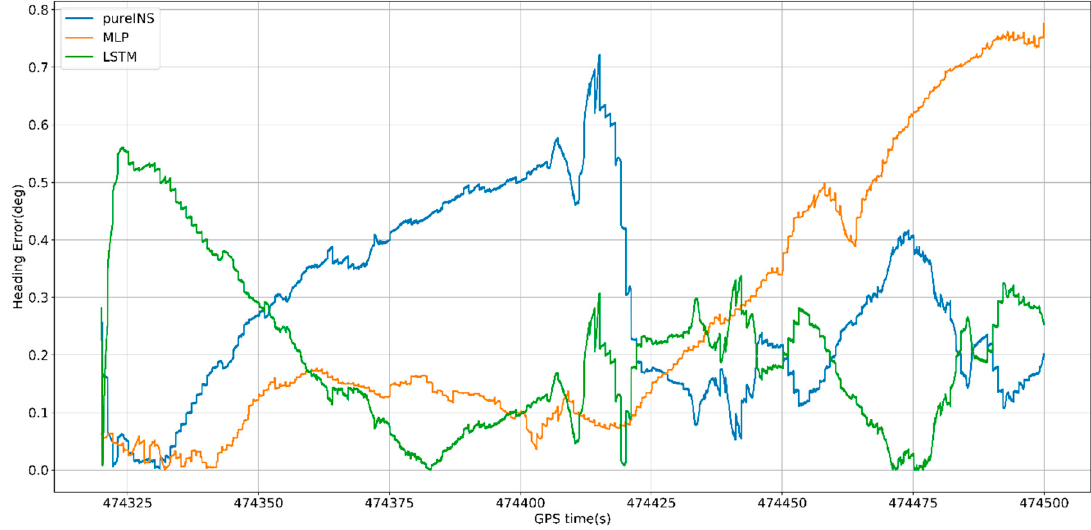
Figure 22. Heading errors of 180 s outages with different algorithms.